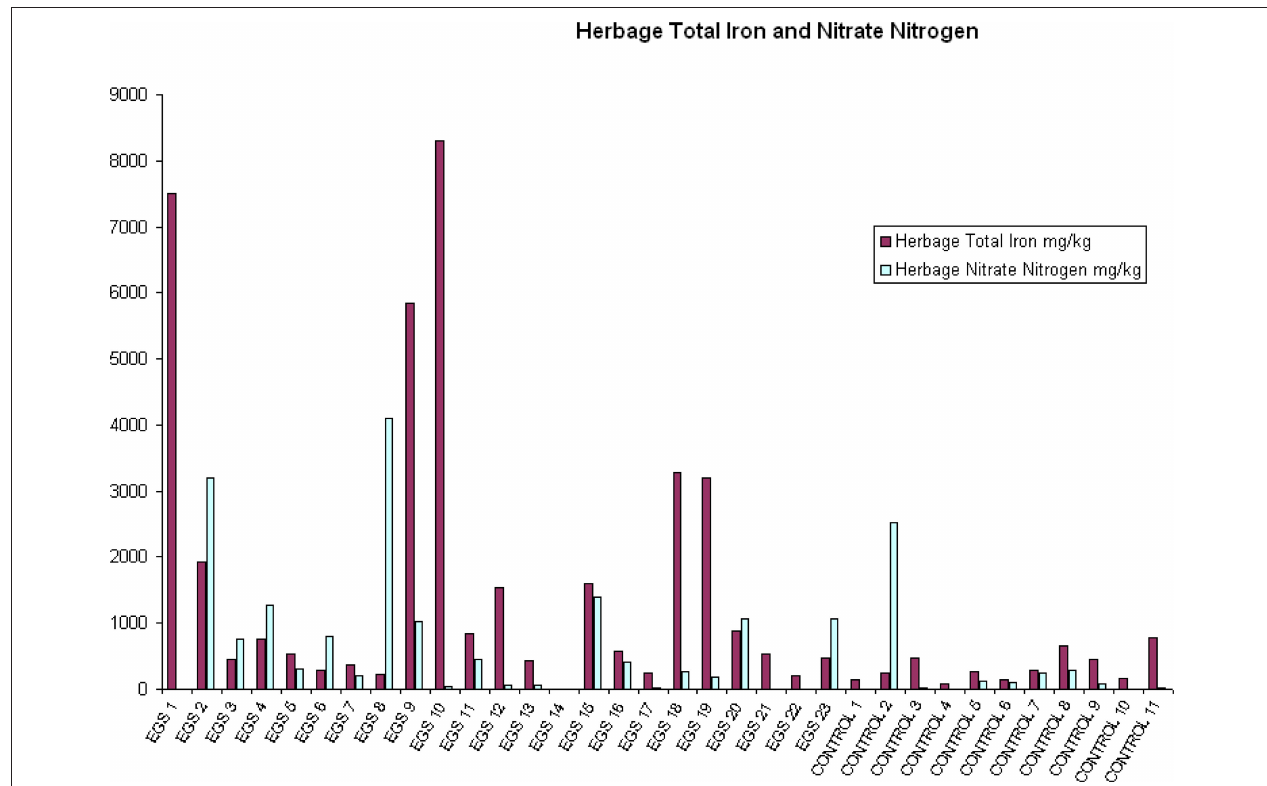
FIGURE 2 | Herbage total iron and nitrate nitrogen. Herbage total iron and nitrate nitrogen (mg/kg) per site (EGS and